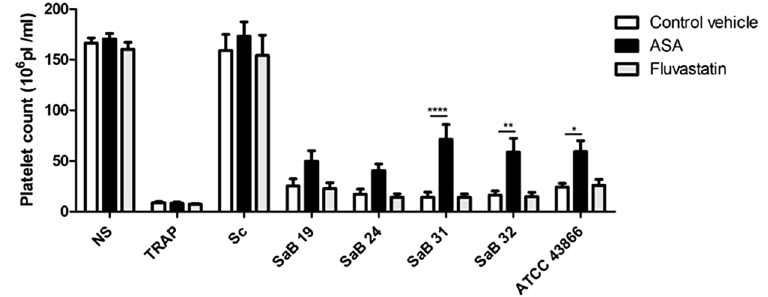
Figure 6. Effect of ASA and fluvastatin on the S. aureus -induced reduction in platelet counts. Platelet counts after a 30-min exposure to staphylococcal strains [clinical strains (SaB), S. condimenti (Sc) or S. aureus ATCC 43866 (ATCC43866)], TRAP (as a positive control) or Tyrode’s buffer (as a negative control, NS), ASA, fluvastatin or water (as a control vehicle) [control vehicle (n = 42), TRAP (n = 40) or Staphylococcus strains (n = 10)]. The data (mean ± SEM) are expressed as the platelet count × 10 6 /ml. * p < 0.05, ** p < 0.01; **** p < 0.0001 (two-way ANOVA with repeated measures and the Bonferroni post hoc test; ASA or fluvastatin vs. control